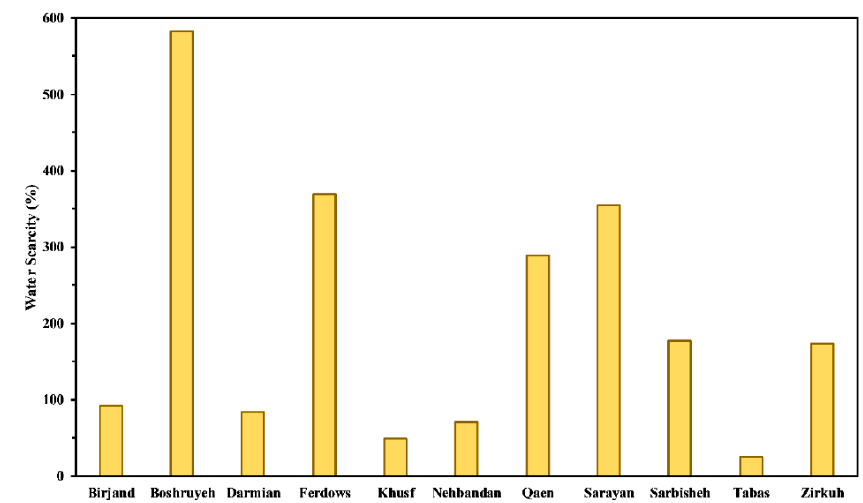
Figure 9. Water scarcity associated with agricultural production within the South